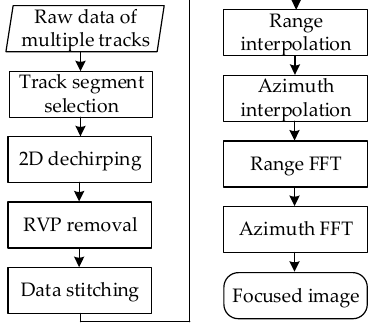
Figure 7. Flowchart of the azimuth super-resolution method.